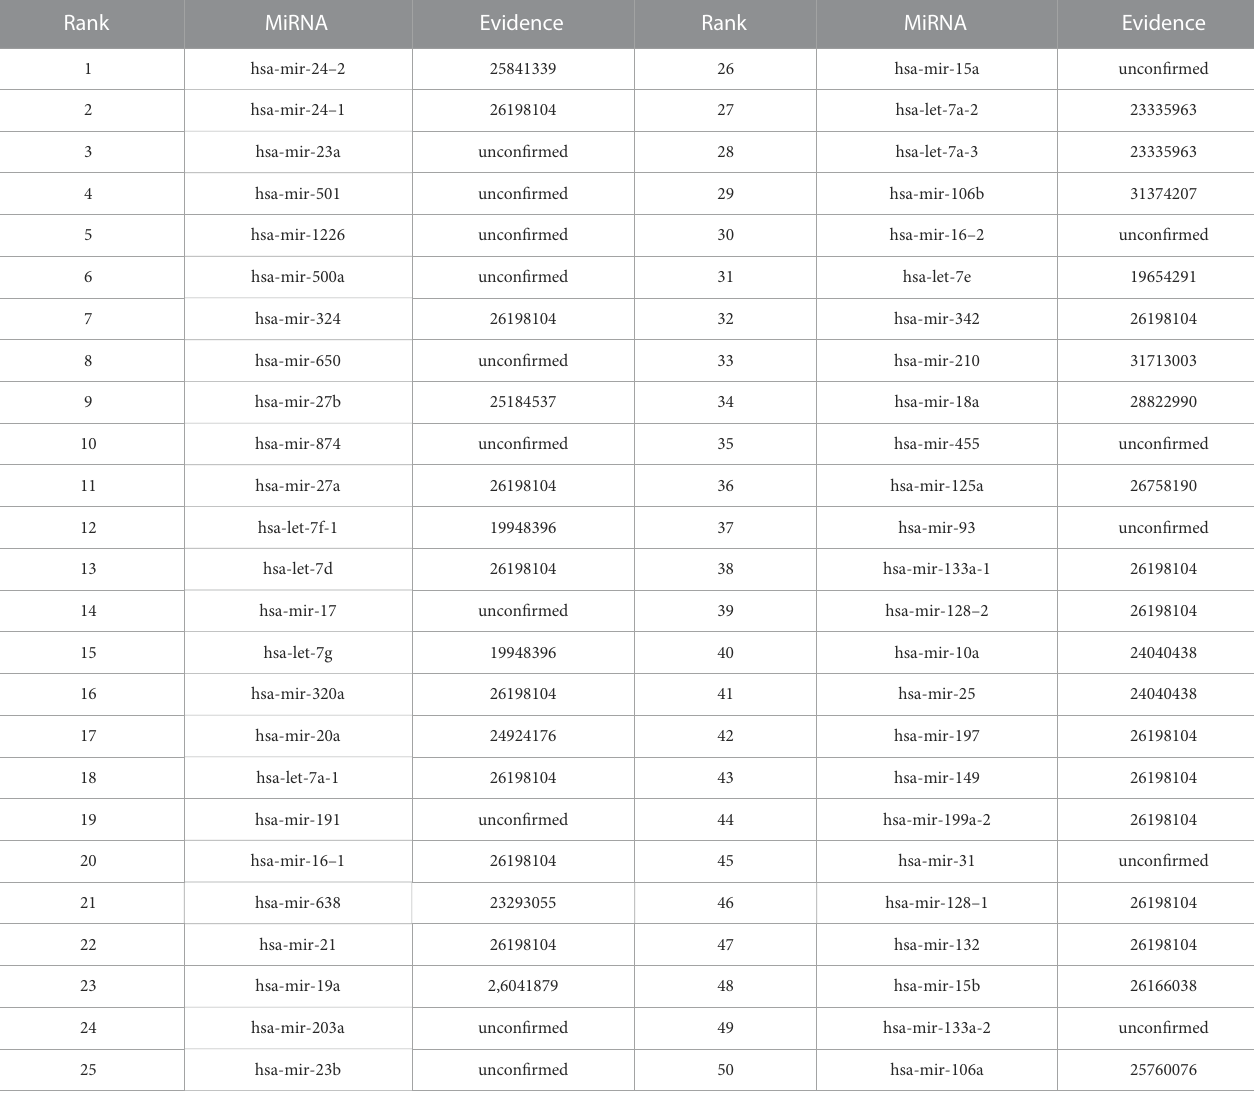
TABLE 6 The top-50 miRNAs related to Gemcitabine are predicted by GNMFDMA.